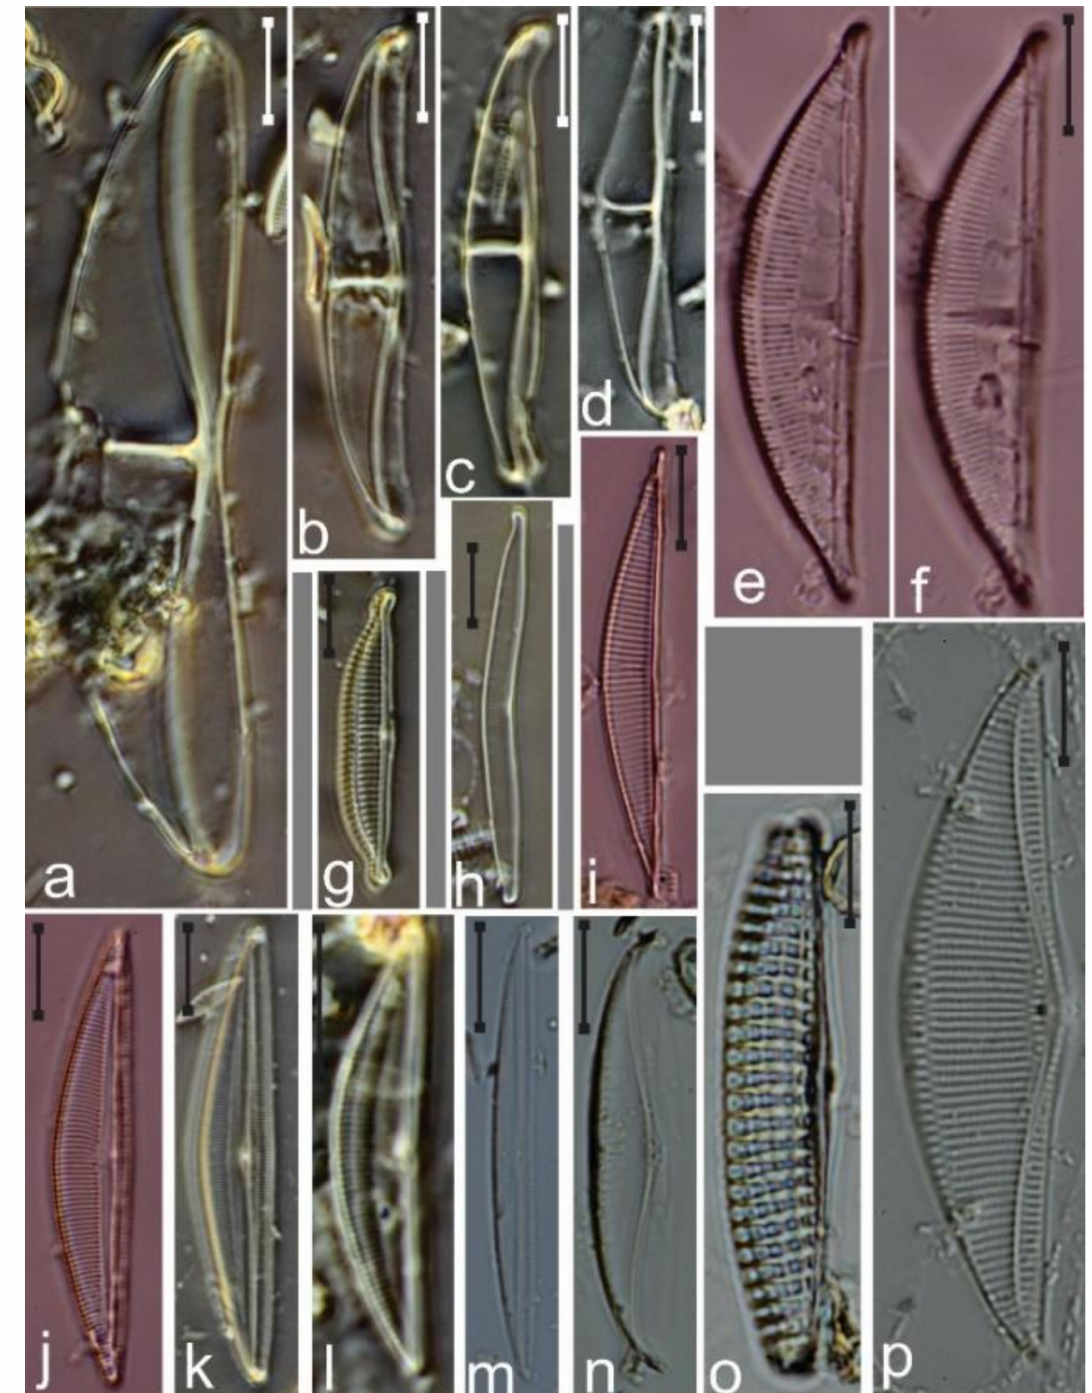
Figure 35. ( a , b ) Amphora cingulata ; ( c , d ) A. laevissima ; ( e , f ) A. grae ff eana ; ( g ) Halamphora exigua ; ( h ) Amphora americana ; ( i ) A. cf. cymbamphora ; ( j ) Seminavis robusta ; ( k ) S. basilica ; ( l ) Amphora beaufortiana ; ( m ) Seminavis barbarae ; ( n ) Amphora obtusa ; ( o ) A. crassa ; ( p ) Tetramphora securicula . Scale bar = 10 µ